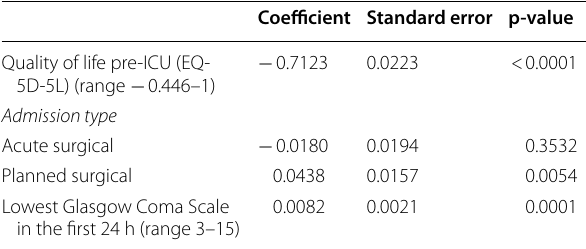
Table 1: Selected variables and their coefficients in the final model Coefficient Standard error